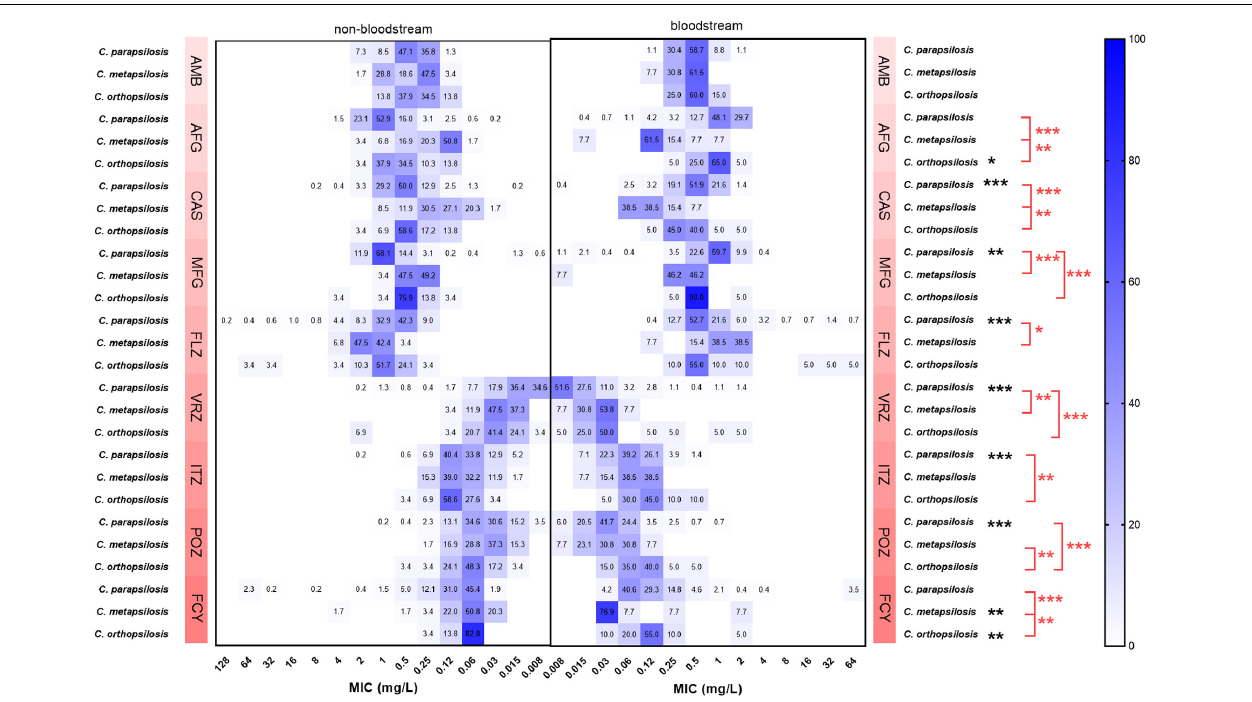
FIGURE 1 | Comparison of the proportions of minimum inhibitory concentration (MIC) distributions of C. parapsilosis complex isolates between bloodstream and non-bloodstream samples. Black *indicates 0.01 < P < 0.5, statistically significant differences of MIC values between bloodstream and non-bloodstream isolates; black **indicates 0.001 < P < 0.01, black ***indicates P < 0.001. Red *indicates 0.01 < P < 0.5, statistically significant differences of MIC values between bloodstream C. parapsilosis complex species; red **indicates 0.001 < P < 0.01, red ***indicates P < 0.001. FLZ, fluconazole; VRZ, voriconazole; ITZ, itraconazole; POZ, posaconazole; MFG, micafungin; AFG, anidulafungin; CAS, caspofungin; AMB, amphotericin B; FCY,